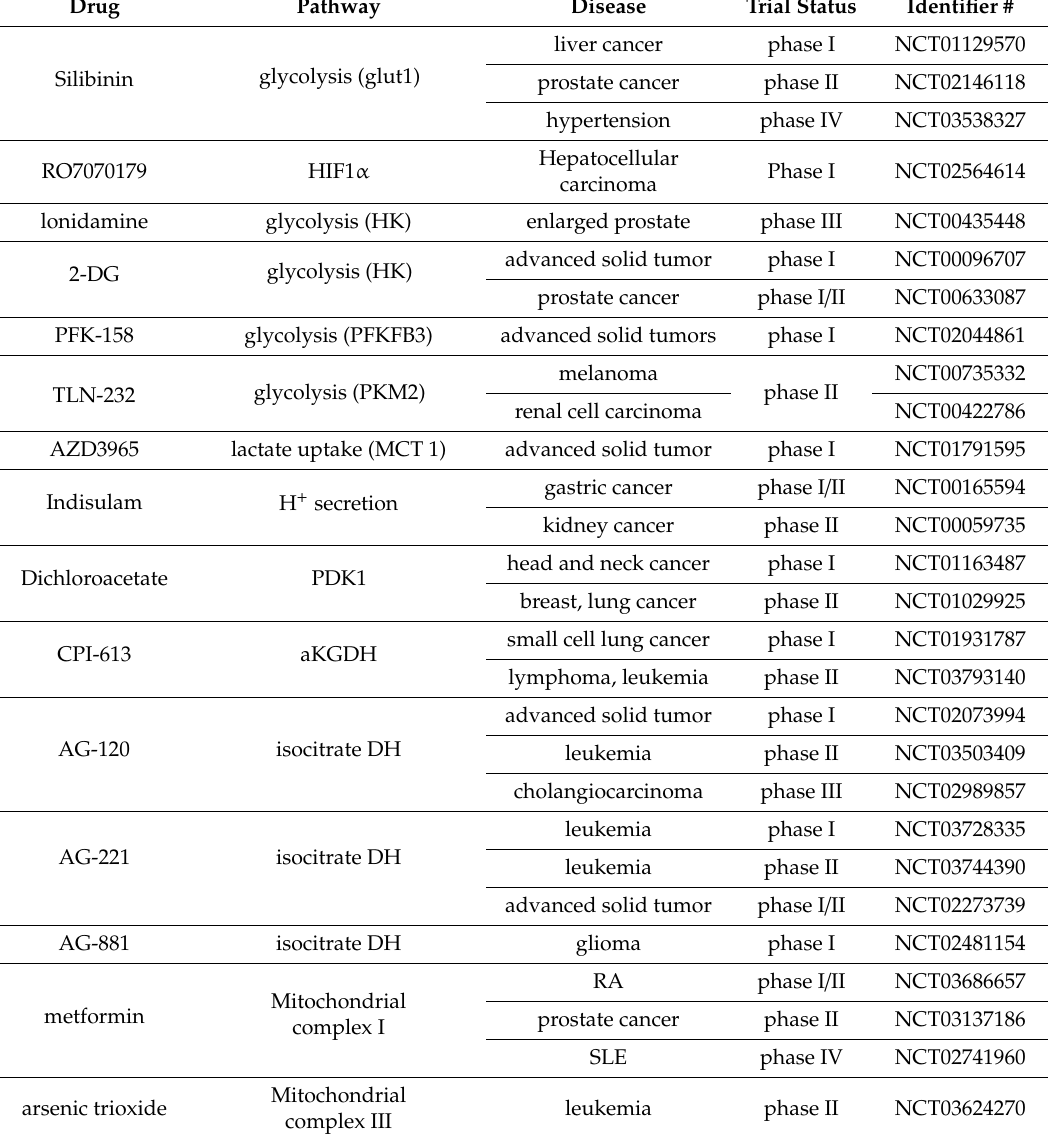
Table 1. Clinical trials of drugs that target various steps of the glycolytic and mitochondrial metabolic pathways.